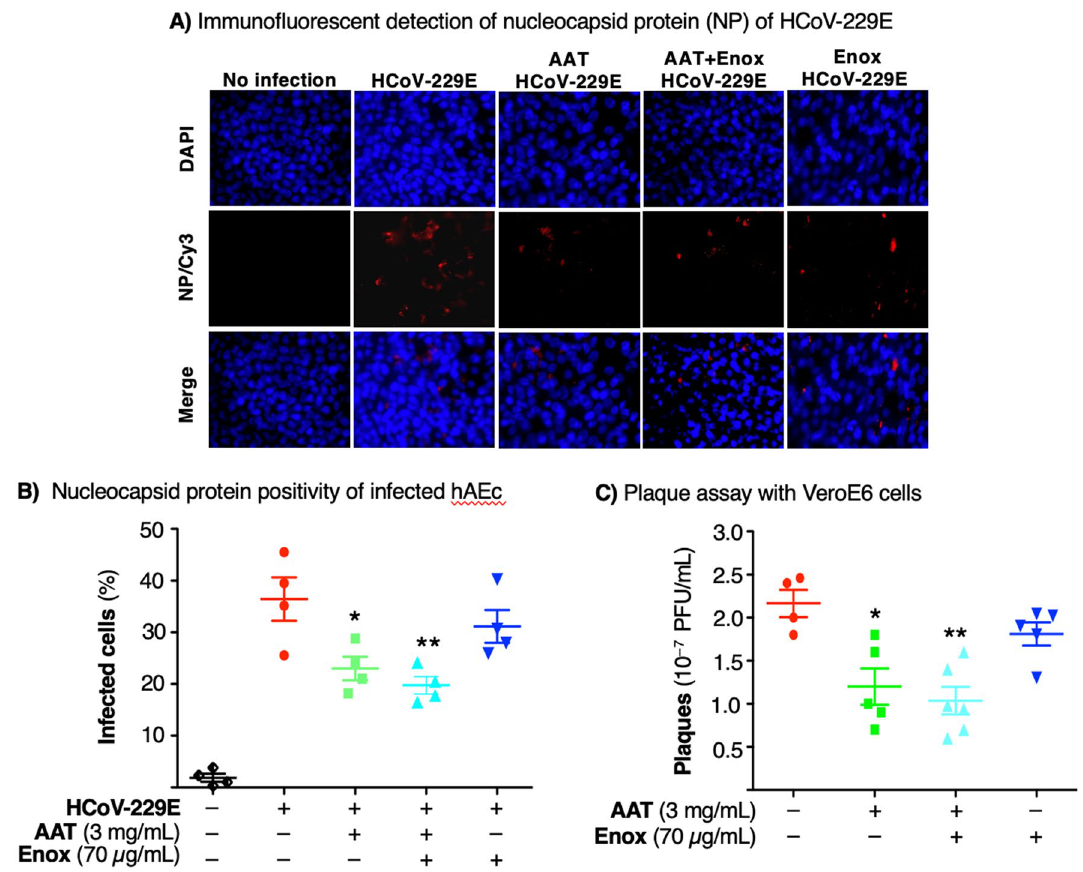
Figure 5. Effects of AAT, enoxaparin, or both on infection of hAEc with HCoV-229E. ( A ) Immunofluorescence analysis of HCoV-229E-infected hAEc grown in air–liquid interface. The hAEc were pre-treated with AAT (3 mg/mL), enoxaparin (70 µg/mL), or both for 1 h, and then infected with HCoV-229E at a multiplicity-of- infection of 1 hAEc:0.01 HCoV-229E. Three days after infection, the cells were fluorescently immunostained for the nucleocapsid protein of HCoV-229E. The nuclei were stained with DAPI. Fluorescent images were taken at a magnification of 400X by confocal microscopy (Carl Zeiss Anxiovert 200 M). ( B ) Percentage of HCoV- 229E-infected hAEc with > 700 total cells counted for each condition. Data shown are the mean ± SEM of three independent experiments. *p < 0.05, **p < 0.01 compared to HCoV-229E infection alone. ( C ) Plaque assay. The apical chamber medium of HCoV-229E-infected hAEc were used to infect VeroE6 cells and incubated for 4–5 days. Infection of the hAEc were done in triplicates and subsequent infection of VeroE6 cells with the supernatant of HCoV-229E-infected hAEc were each done in triplicates. Thus, the data shown are the triplicate means ± SEM of the original triplicate experiments. *p < 0.05 and **p < 0.01 compared to cells infected with HCoV-229E only without treatment. hAEc = primary human airway epithelial cells, HCoV-229E = human coronavirus approximately three quarters of its circumference (Figs. 6D,E and S5A). Docking analysis suggests that heparin molecules may act as electrostatic bridges between AAT and TMPRSS2, likely stabilizing an otherwise subop-